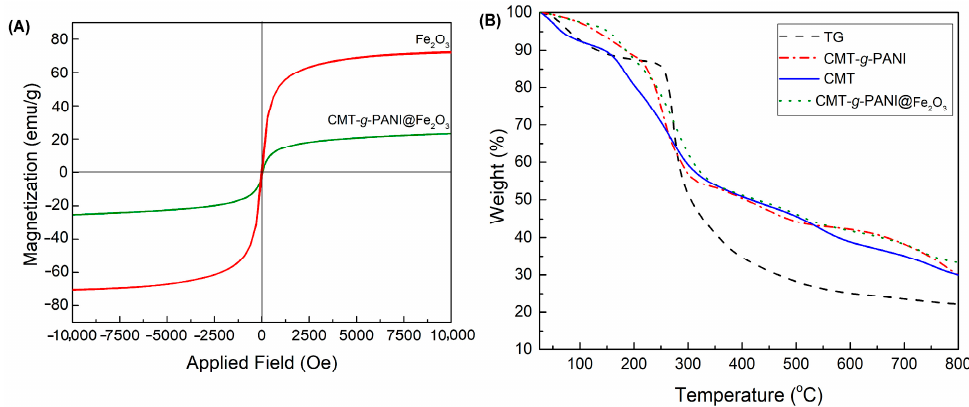
Figure 4. VSM curves of Fe 2 O 3 , and CMT-g-PANI@Fe 2 O 3 ( A ) and TGA thermograms ( B ) of TG, CMT, CMT-g-PANI, and CMT-g-PANI@Fe 2 O 3 .